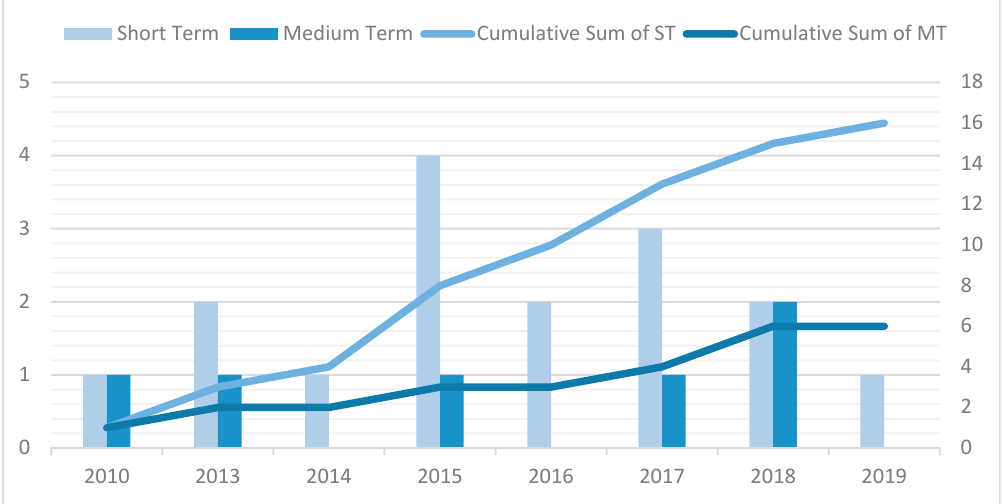
Figure 6. Number of studies and their cumulative sum over the years for short- and medium-term water demand forecasting.